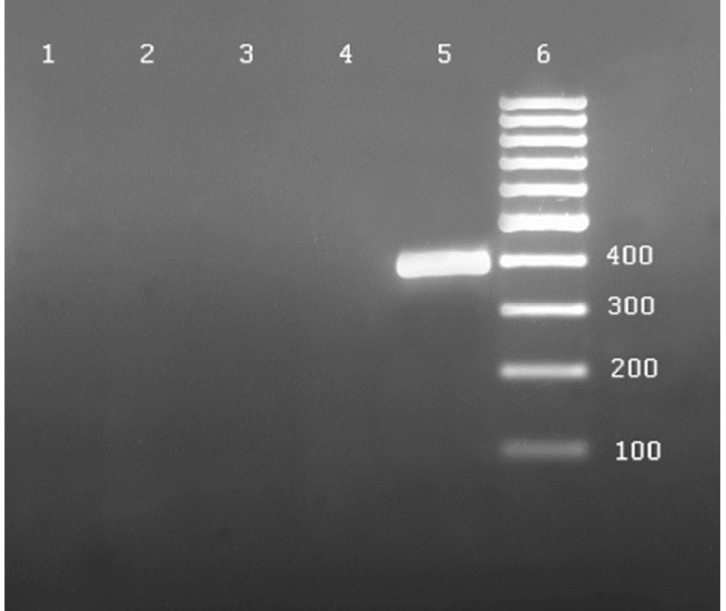
Figure 2. PCR products generated by amplification of the Nsyl-elF4E1 marker (402 bp) linked to the Va gene. Lanes:1, N. mutabilis ; 2, N. alata ; 3, N. forgetiana ; 4, N. tabacum cv. VAM; 5, N. tabacum cv. Burley 21; 6, DNA ladder 100 bp.